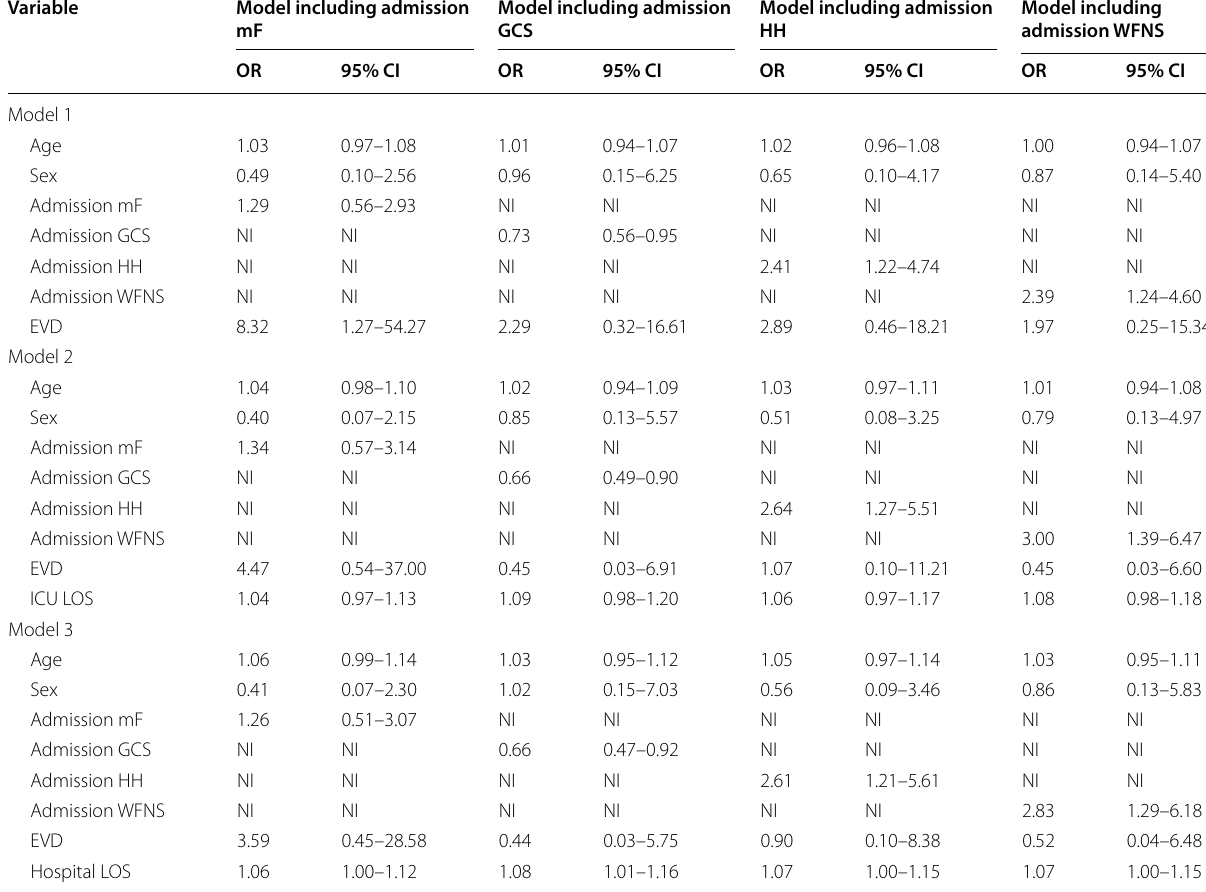
Table 4 Odds ratios in multivariable models for the outcome mRS > 2 at 6